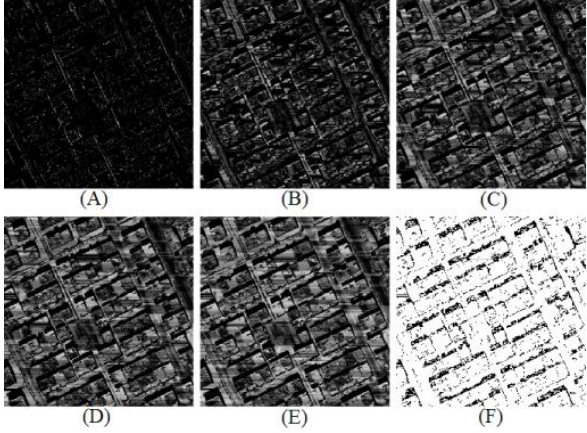
Figure 4. Subtraction of main image from reconstructed image by a SE with 180 degree direction and a scale of, A. 5×5, B.